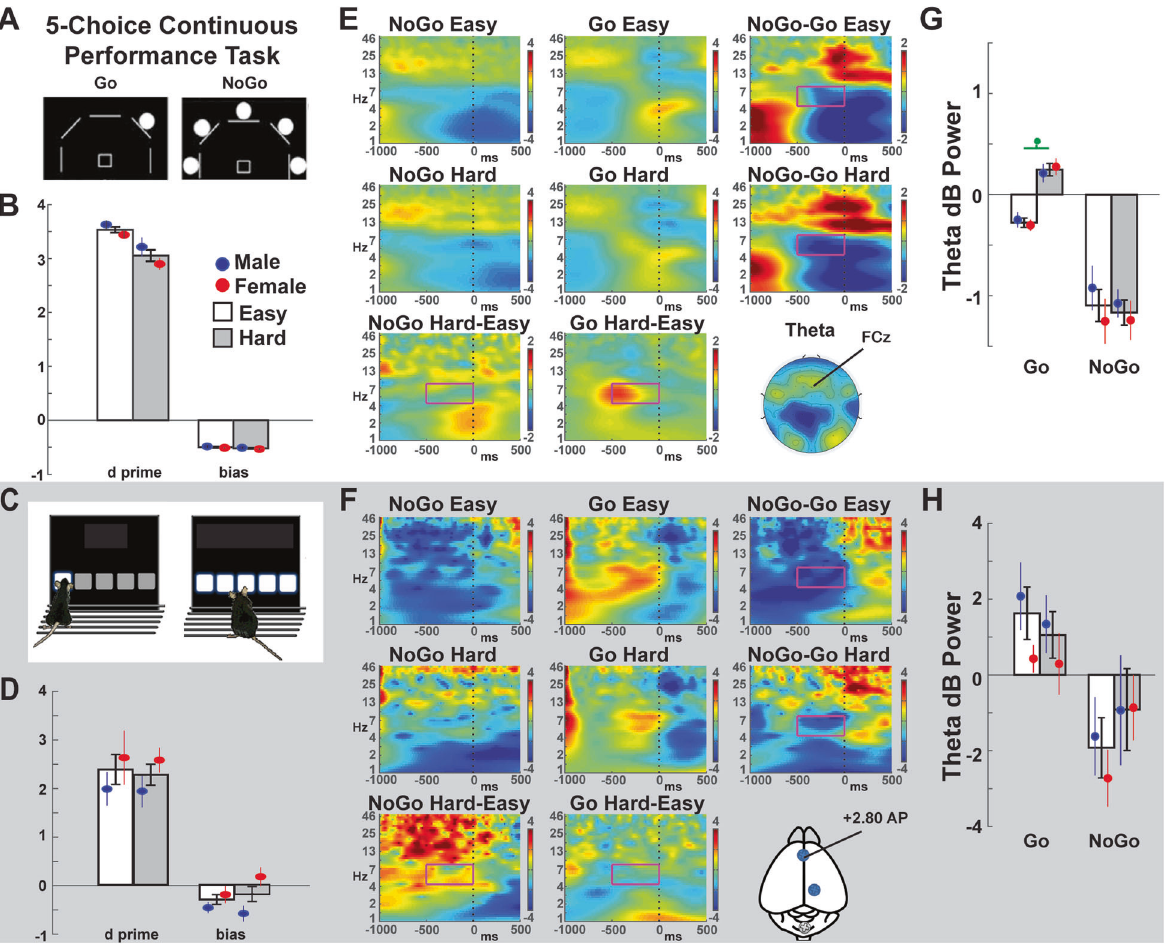
Fig. 4 The fi ve-choice continuous performance task (5C-CPT) had two levels of dbif fi culty. A – B In humans, dif fi culty was manipulated with easy (unmasked) vs. hard (masked) visual contrast conditions. Dif fi culty altered d prime but not bias. C – D In mice, dif fi culty was modulated with easy (3 s delay) vs. hard (1.5 s delay) conditions. Task demand did not change d prime or bias in mice. E – F Time-frequency plots of response-locked data at FCz in humans or the anterior lead in mice. Since a correct nontarget (nogo) condition does not require a response, these epochs were time-locked to the end of the delay period. The magenta boxes show the theta-band tf-ROI. G – H ) EEG tf-ROI quanti fi cation of the go easy vs. go hard difference in preresponse theta power. Green asterisks indicate statistically signi fi cant ( p < 0.05) within-subject frequency ranges for each tf-ROI. All effect sizes are presented as partial eta-squared ( p η 2 ) or Cohen ’ s d (mean difference divided by the pooled standard deviation).